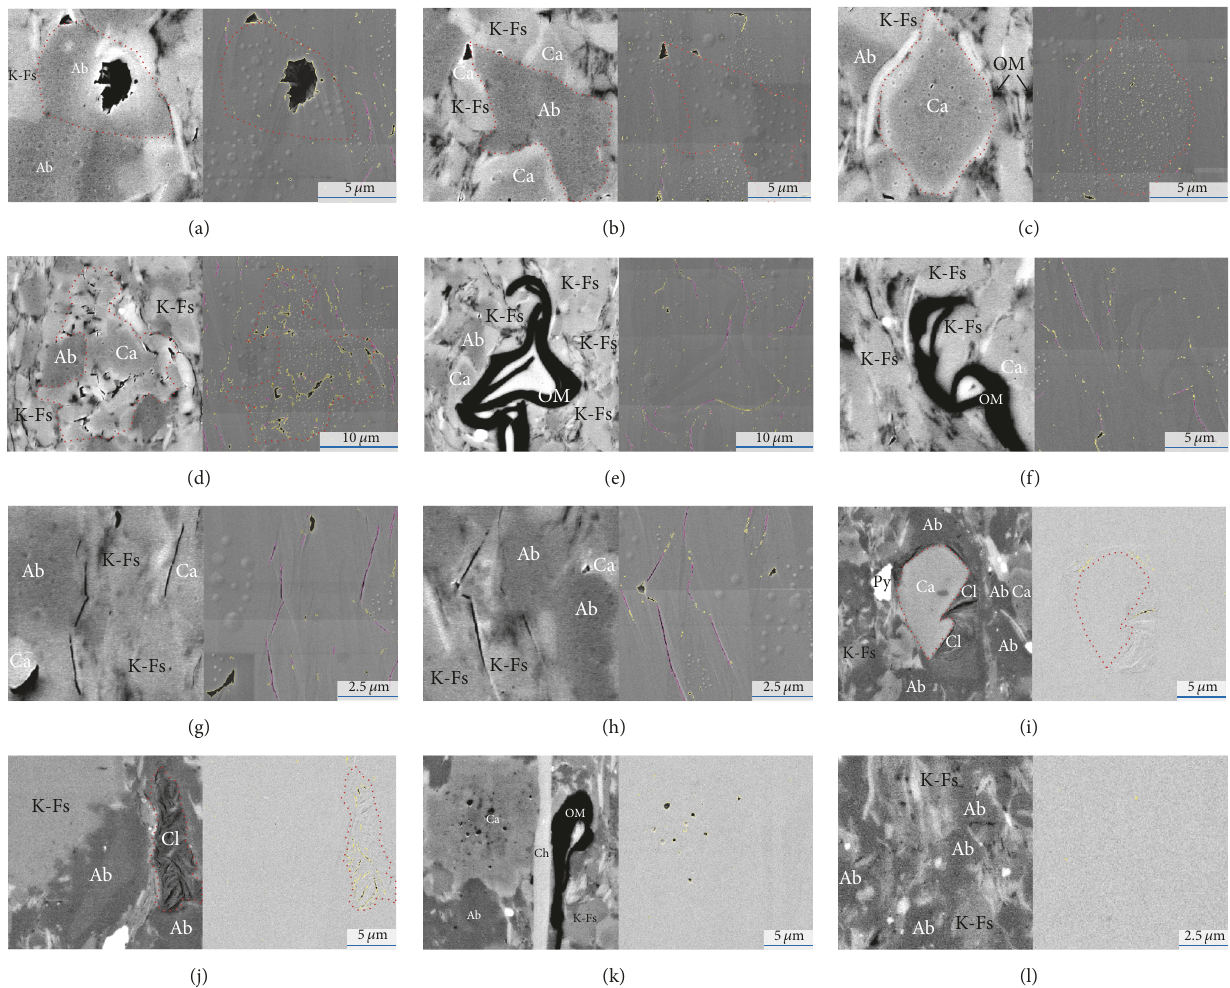
Figure 6: Mineralogical, microstructural, and morphological features of clasts (red), pore space (yellow/purple), and rock matrix of sample NJ-019 and NJ-023. Grains occur in a wide range of sizes but were chosen according to their characteristic properties for this illustration. Porosity is predominantly distributed between clasts and OM interfaces ( InterP ), representing very narrow elongated slits along grain boundary interfaces within the polycrystalline matrix. Mineral phases are as follows: Ab, albite; Ca, carbonate; Ch, chlorite; Cl, clay; K-Fs, potassium feldspar; OM, organic matter; Py,